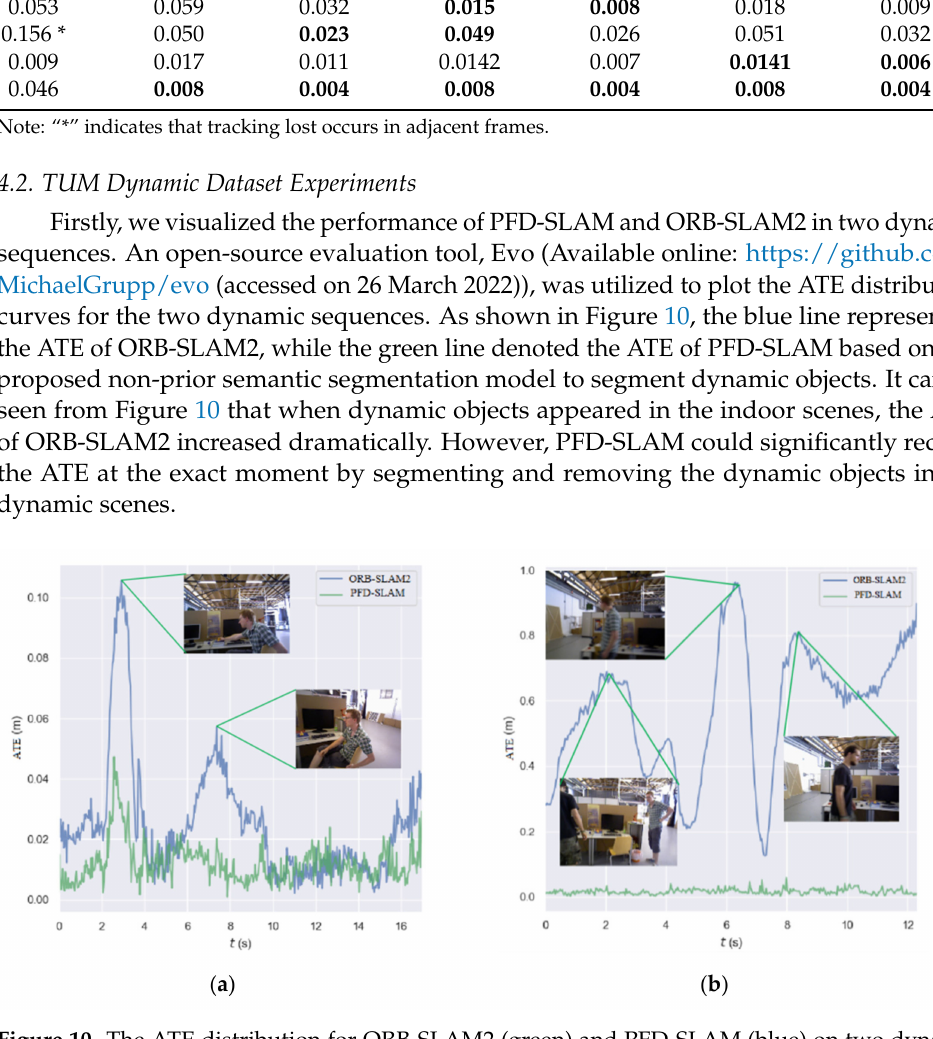
Figure 10. The ATE distribution for ORB-SLAM2 (green) and PFD-SLAM (blue) on two dynamic datasets. The images of green lines show dynamic objects in the scenes. ( a ) Part (1341845959- 1341845979) of “ fr3_sitting_half_sphere ”; ( b ) Part (1341846313-1341846325) of “ fr3-walking -xyz